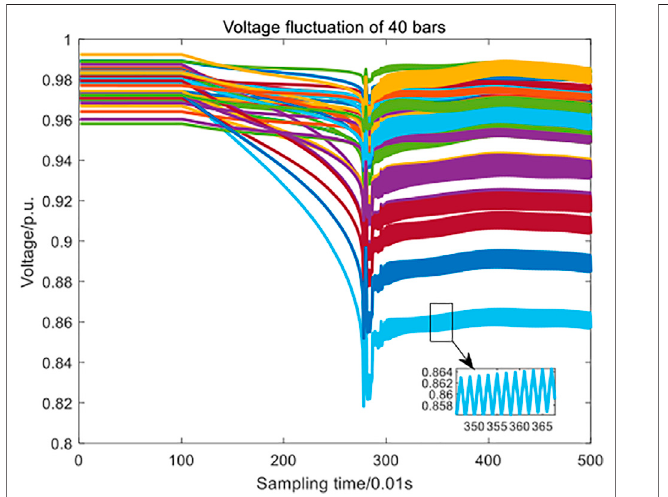
FIGURE 8 | MSR index of case